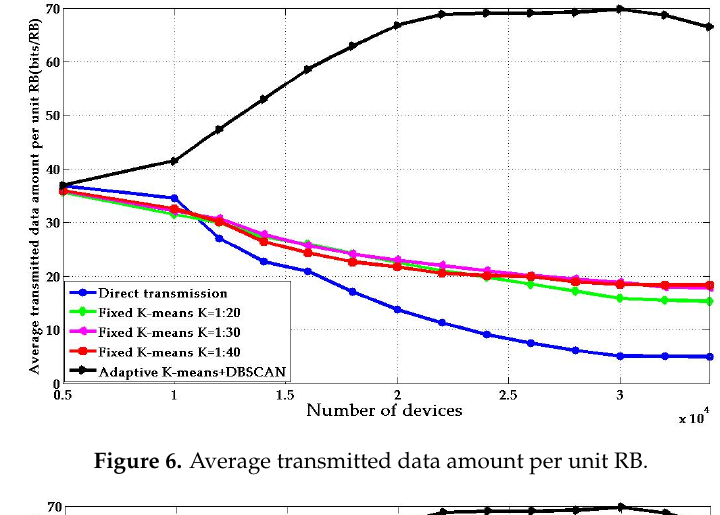
Figure 5. Average number of Resource Block (RB)s used per unit of time. Figure 6. Average transmitted data amount per unit RB. Figure 6. Average transmitted data amount per unit RB.